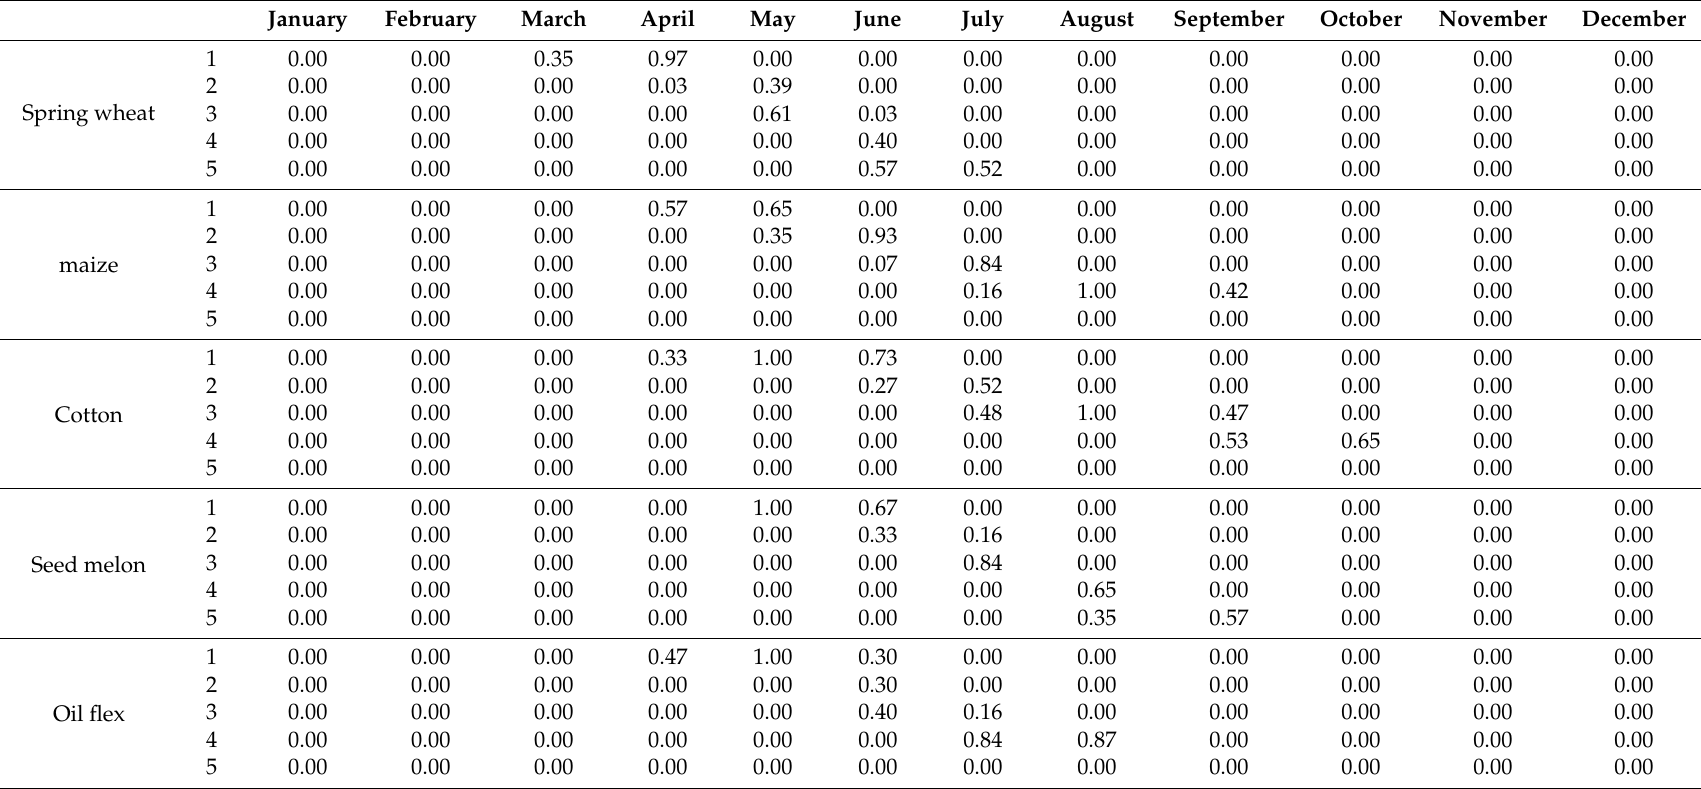
Table 4. Growth stage-time period transformation variable ( q ijt